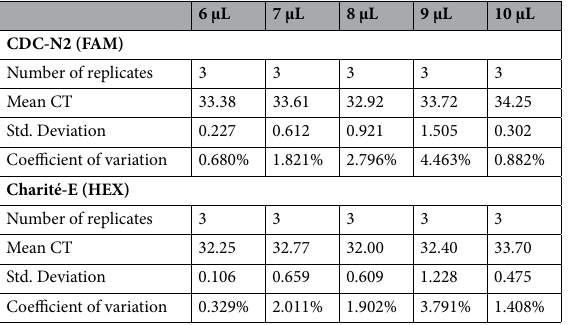
Table 5. Descriptive statistics showing the effect of controlled variation of volumes of saliva in a 20 µl